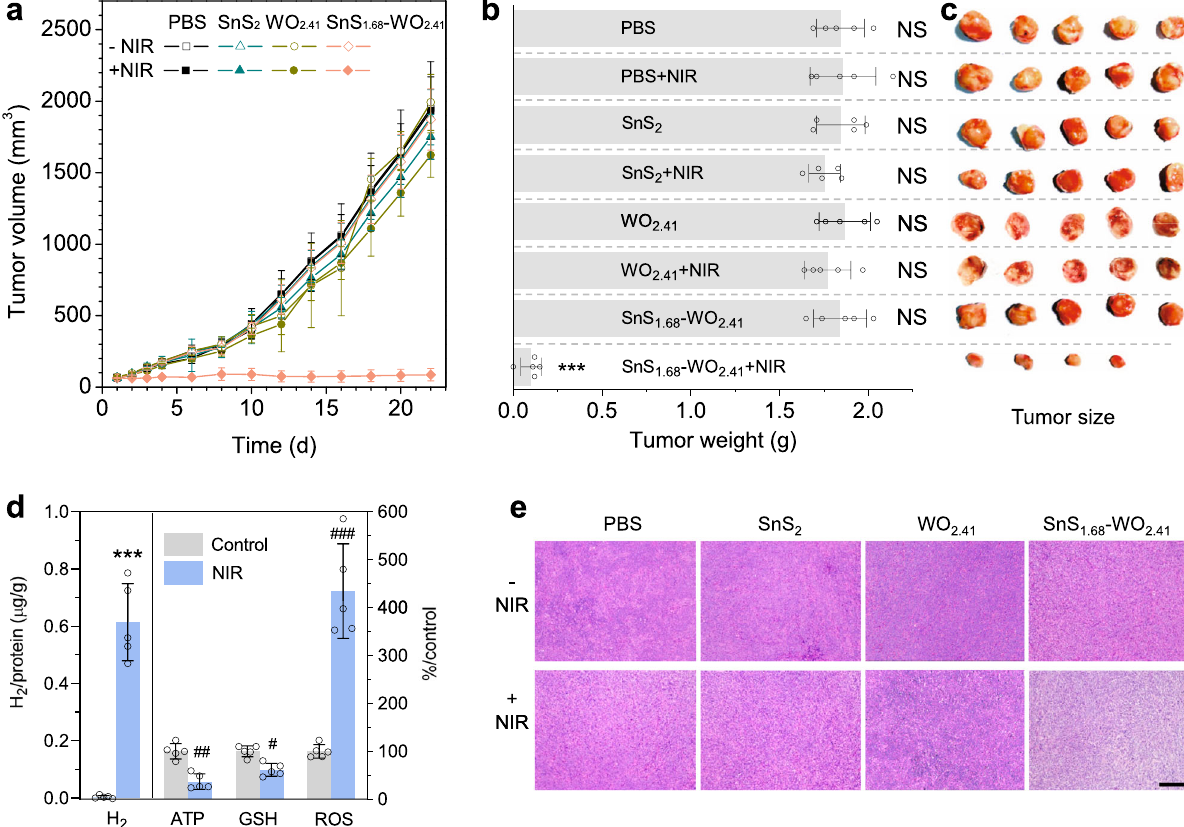
Fig. 5 In vivo combined hole/hydrogen therapy performances of the SnS 1.68 – WO 2.41 nanocatalyst. The monitoring of 4T1 tumor volume ( a ), the weight ( b ) and size ( c ) of extracted 4T1 tumors after 22-day treatment ( n = 5 biologically independent samples), the intratumoral H 2 , ATP, GSH, and ROS levels ( d ) before and after NIR irradiation (20 min, 0.5 W/cm 2 ) on nanocatalyst-treated tumor mice ( n = 5 biologically independent samples), and the HE stained tumor tissue slices ( e ). Scale bar, 200 μ m. P values were calculated by the two-tailed Student ’ s t -test ( # P = 0.000653, ## P = 0.00007, ### P = 0.000015, *** P < 0.000001; NS, no signi fi cant difference). Data are presented as mean values ±